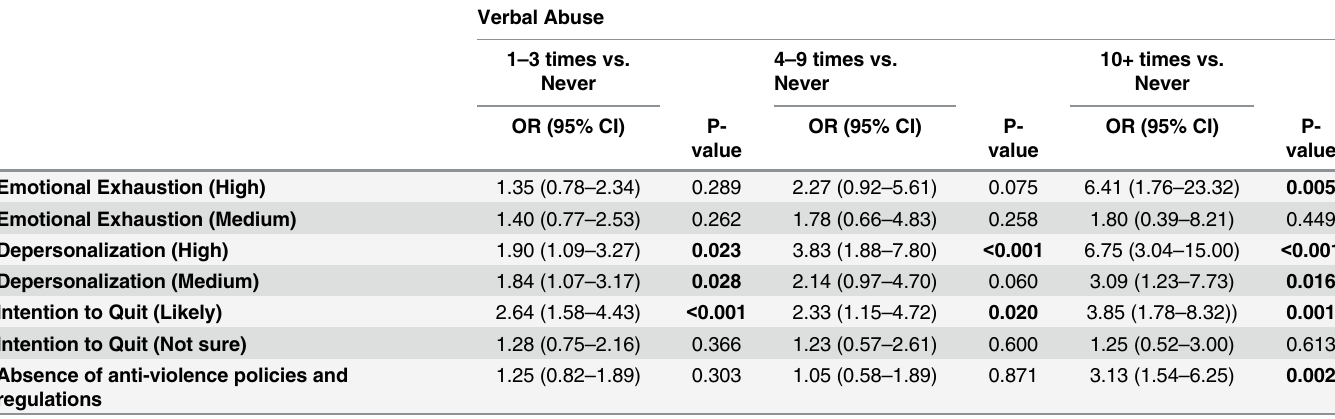
Table 4. Multinomial logistic regression model on exposure to verbal